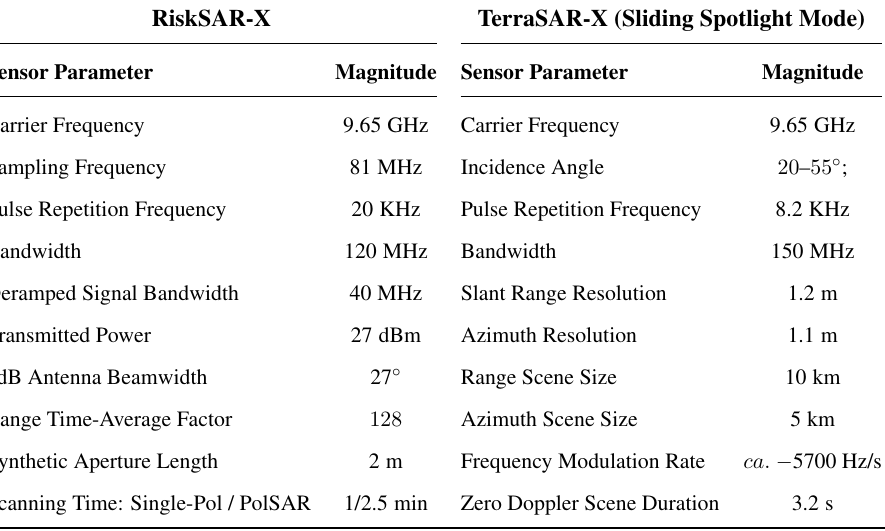
Table 1. RiskSAR-X and Sliding Spotlight TerraSAR-X setting